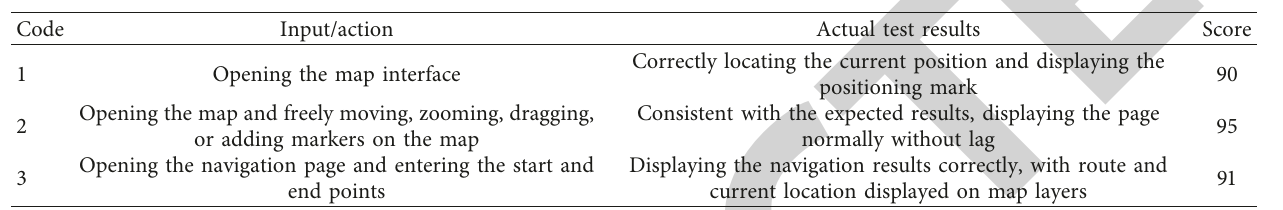
Table 3: Navigation system functional test results.